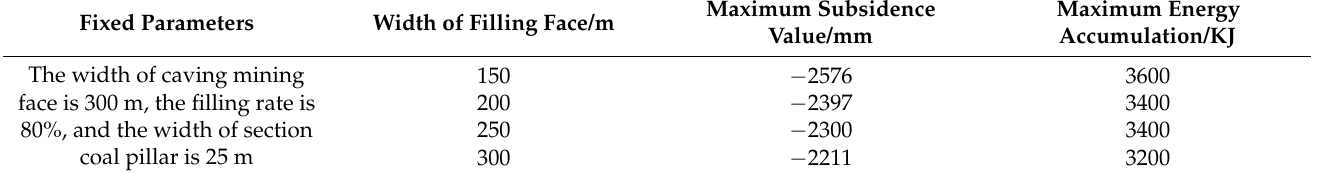
Table 10. Statistical table of surface subsidence and energy polling extreme values in different filling face scale.